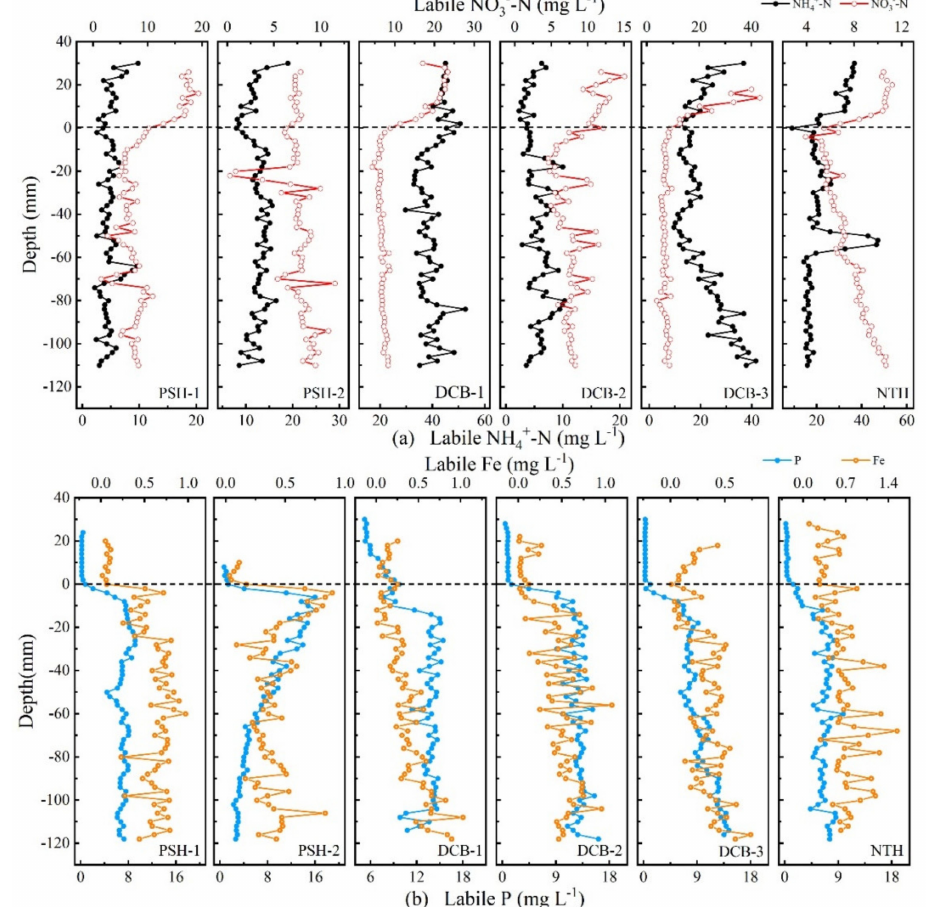
Figure 2. Distribution of labile NH 4+ -N and labile NO 3 − -N in sediment-water profile ( a ), and distribution of labile P and labile Fe in sediment-water profile ( b ). The dotted lines at a depth of zero show the position of the